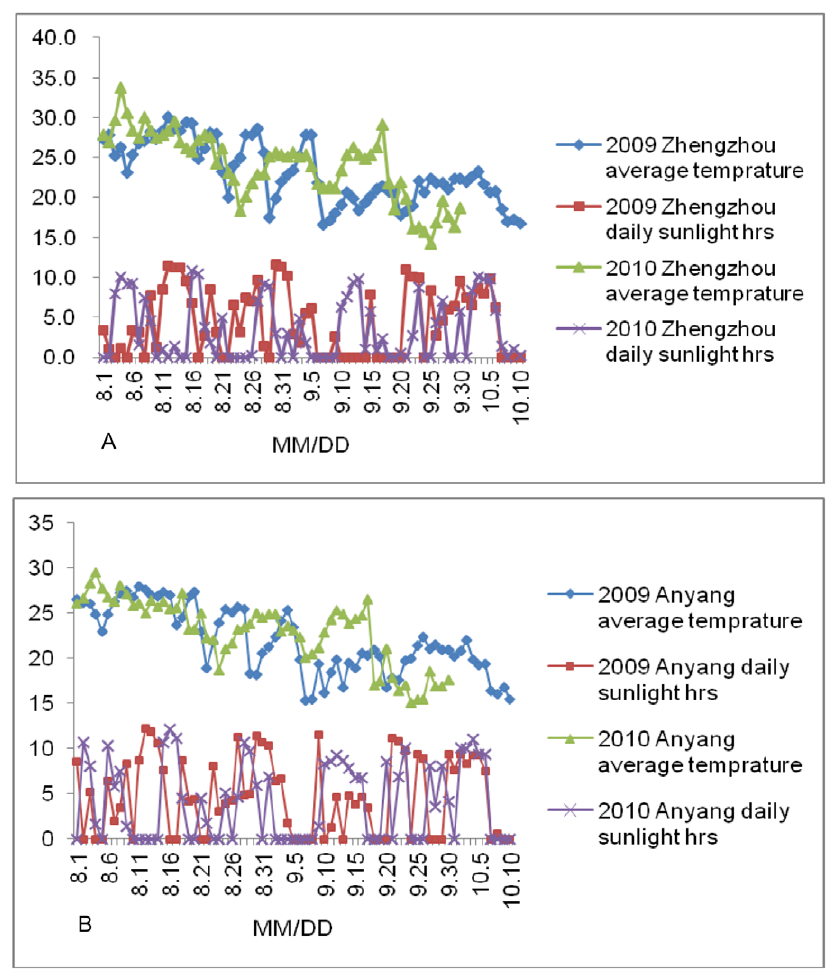
Figure 1. Two main climate factors in maize grain filling duration in 2009–2010 at Zhengzhou (a) and Anyang (b).